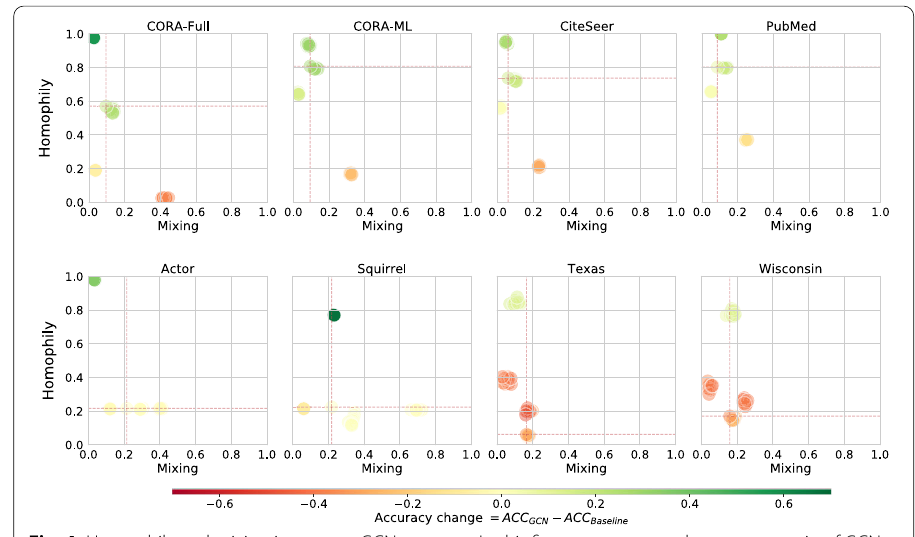
Fig. 4 Homophily and mixing impact on GCN accuracy. In this figure, we present the accuracy gain of GCN over the feature-only baseline (with hue) as a function of mixing (x-axis) and homophily (y-axis). The red dashed lines represent the mixing and the accuracy of the original graph (the point at their intersection in each sub-figure is the original graph). We notice a change in hue along the y-axis, and not the x-axis. This shows a strong impact of homophily on the accuracy gain, while mixing does not have such a strong impact. Note, high mixing and high homophily cannot be achieved with our manipulations at the same time, e.g., cases of pair-wise homophilic relations without any community